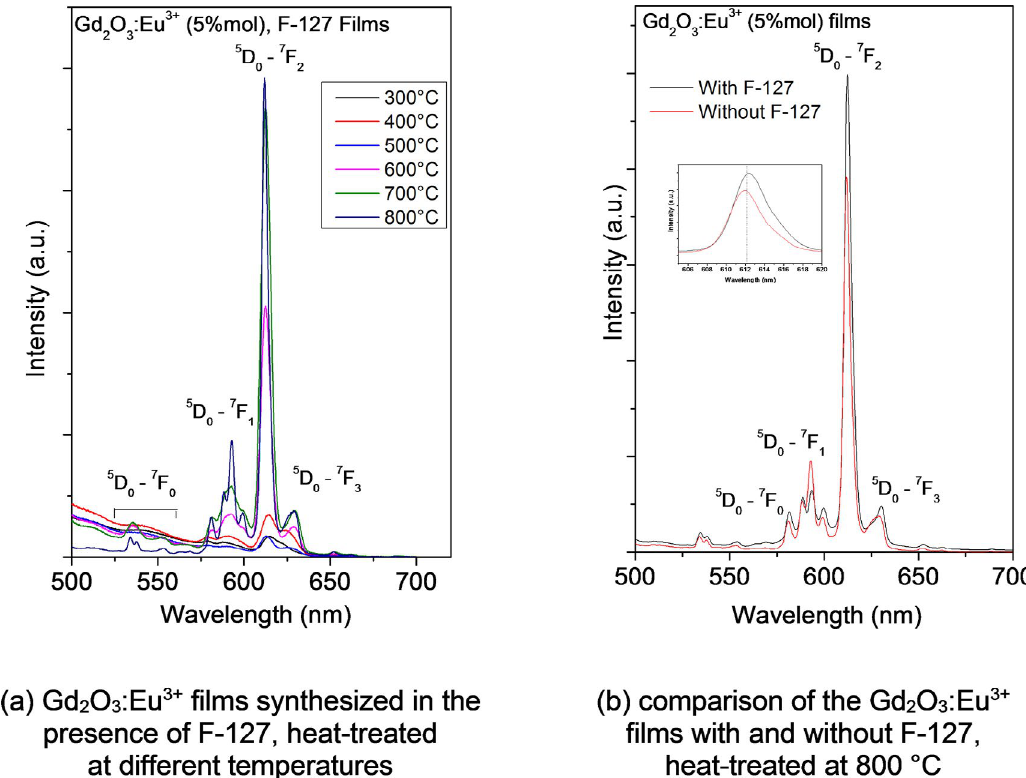
O :Eu 3+ films synthesized in the presence of F-127, heat-treated at different temperatures and 2 3